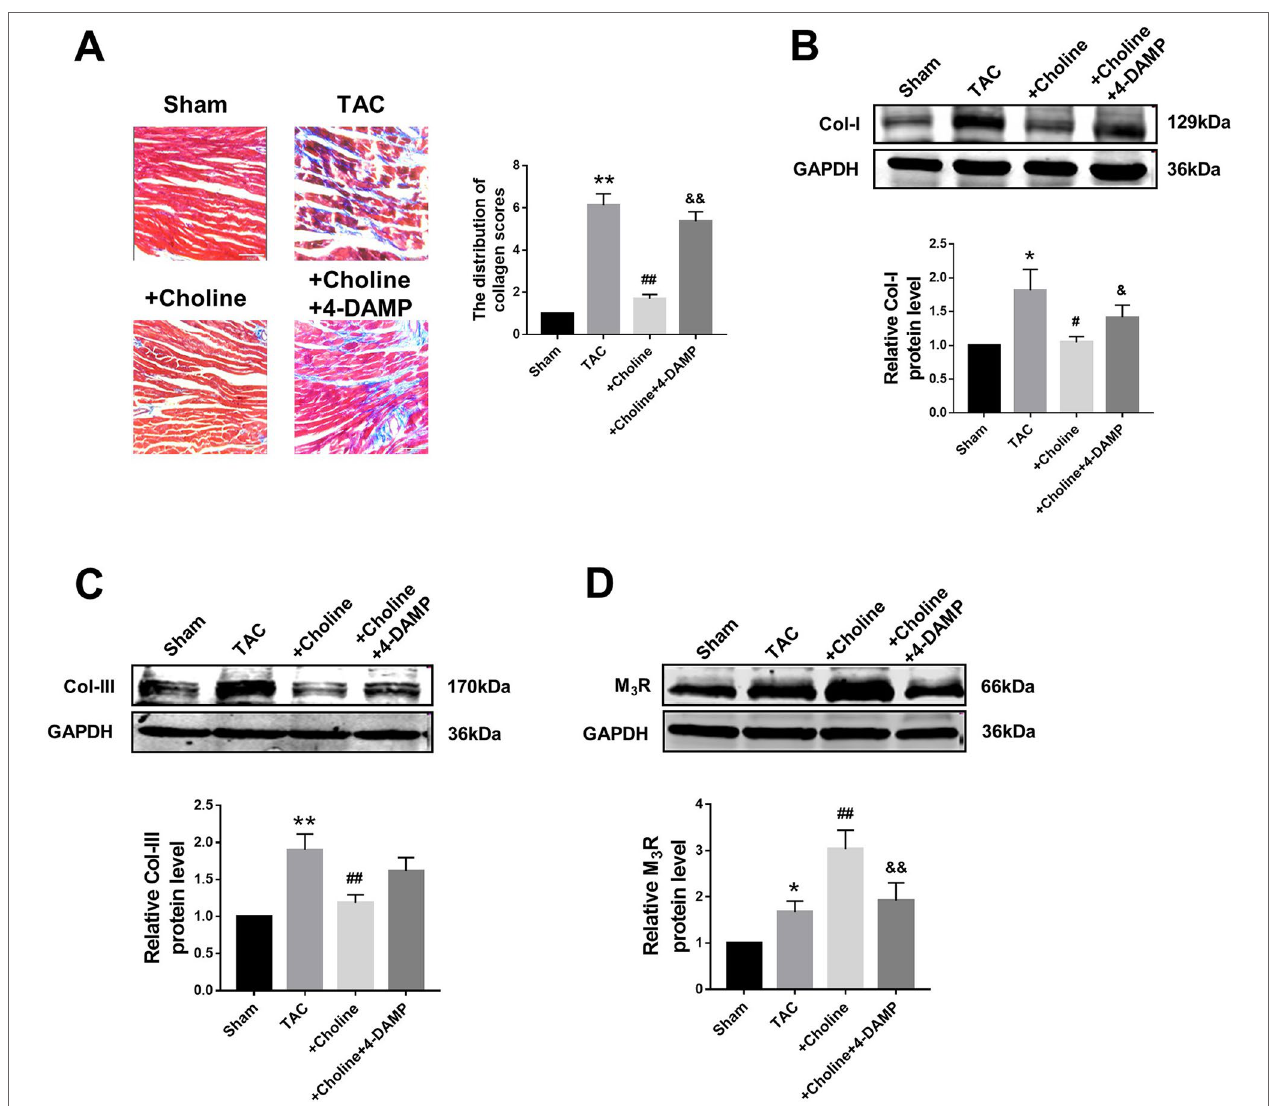
FIgURe 4 | Effects of choline on transverse aortic constriction (TAC)-induced myocardial fibrosis. (A) Representative heart section with Masson staining in the experimental groups, scale bar: 100 μm. ** p < 0.01 vs. sham, ## p < 0.01 vs. TAC, && p < 0.01 vs. choline, n = 5. (B) Effects of choline and 4-diphenylacetoxy- N - methylpiperidine methiodide (4-DAMP) on the protein level of collagen I. * p < 0.05 vs. sham, # p < 0.05 vs. TAC, & p < 0.05 vs. choline, n = 8. (C) Effects of choline and 4-DAMP on the protein level of collagen III. ** p < 0.01 vs. sham, ## p < 0.01 vs. TAC, n = 8. (D) Cardiac M 3 muscarinic acetylcholine receptor protein level after TAC surgery and choline or 4-DAMP treatment. * p < 0.05 vs. sham, ## p < 0.01 vs. TAC, && p < 0.01 vs. choline, n =